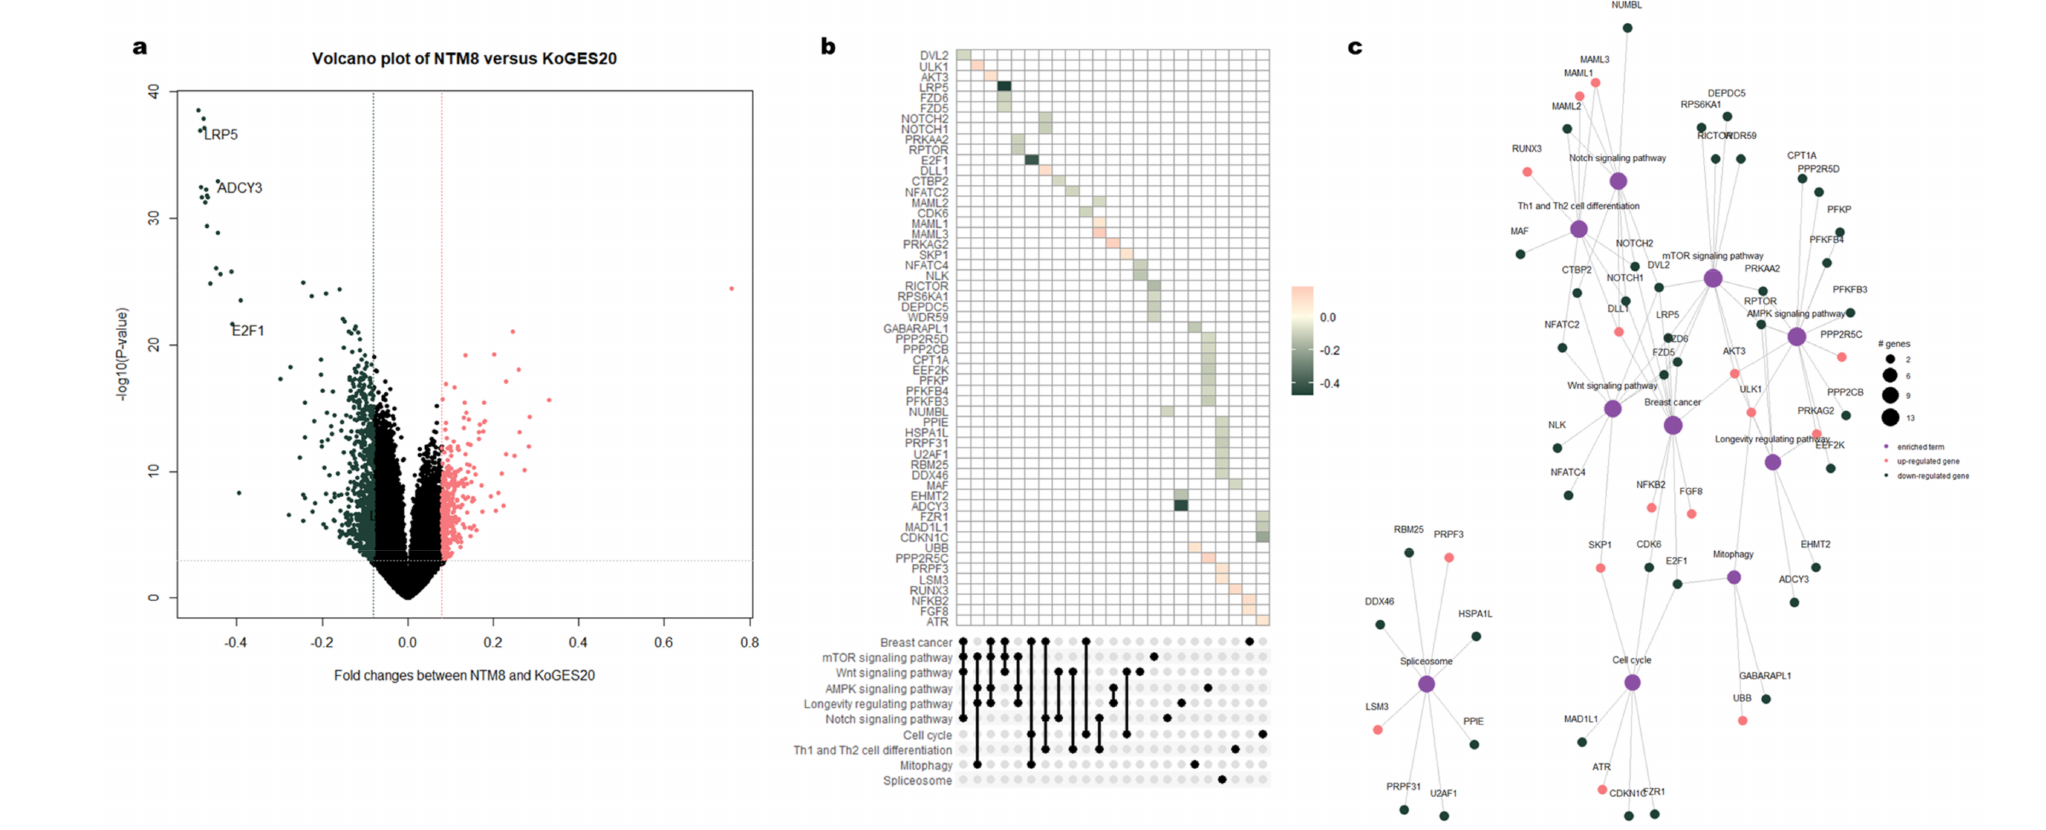
Figure 3. Enriched terms and functional enrichment network of DMRs between eight patients with NTM and the healthy controls. ( A ) Volcano plot of DMRs (defined as a fold change in methylation >0.08 (red) or < − 0.08 (green) with P < 0.001) in eight patients with NTM. ( B ) Upset plot indicating the methylation patterns of 31 genes and 10 associated enriched terms. ( C ) Network plot: the color of the circles represents the methylation patterns in genes from patients with a poor prognosis, and the size of the circles represents the number of genes